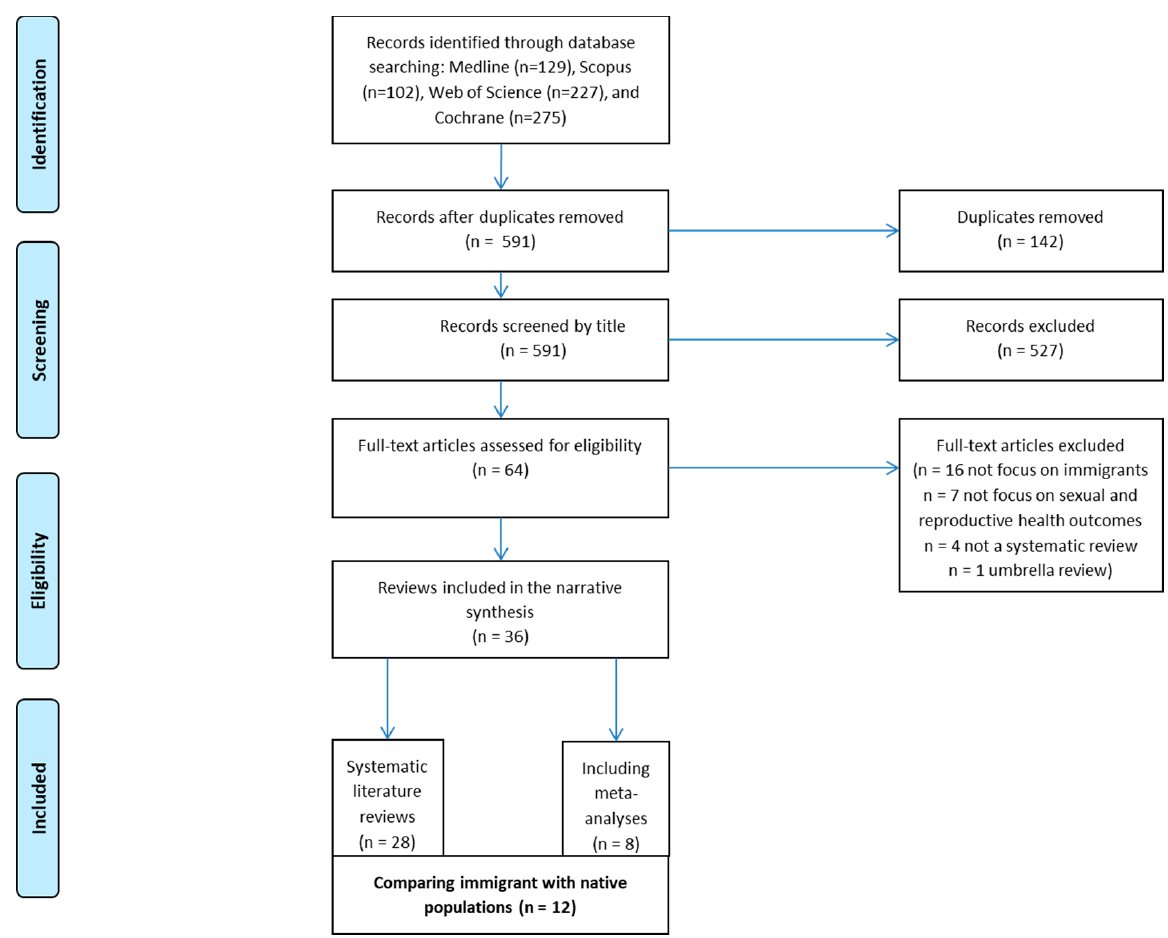
Figure 1. Preferred reporting items for systematic reviews and meta-analysis (PRISMA) flow-chart of study selection pro- cedure.